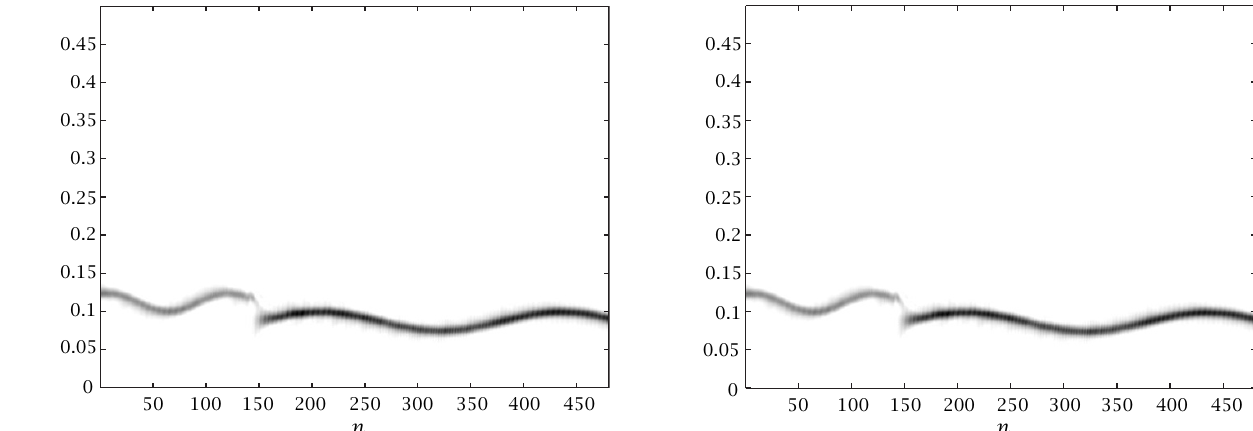
Figure 1: Time-frequency spectrum of a regularly sampled version of f(t) . The signal is similar to the QPO (Quasi-Periodic Oscilla- tion) presented in [1, 2].